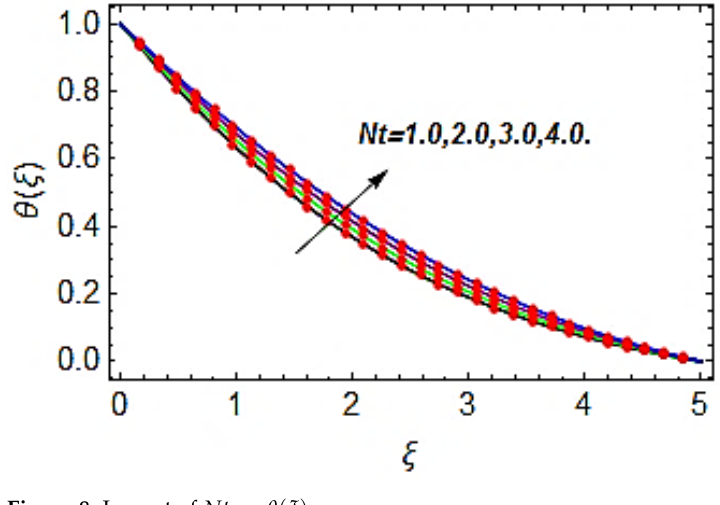
Figure 8. Impact of Nt on θ ( ξ ) .